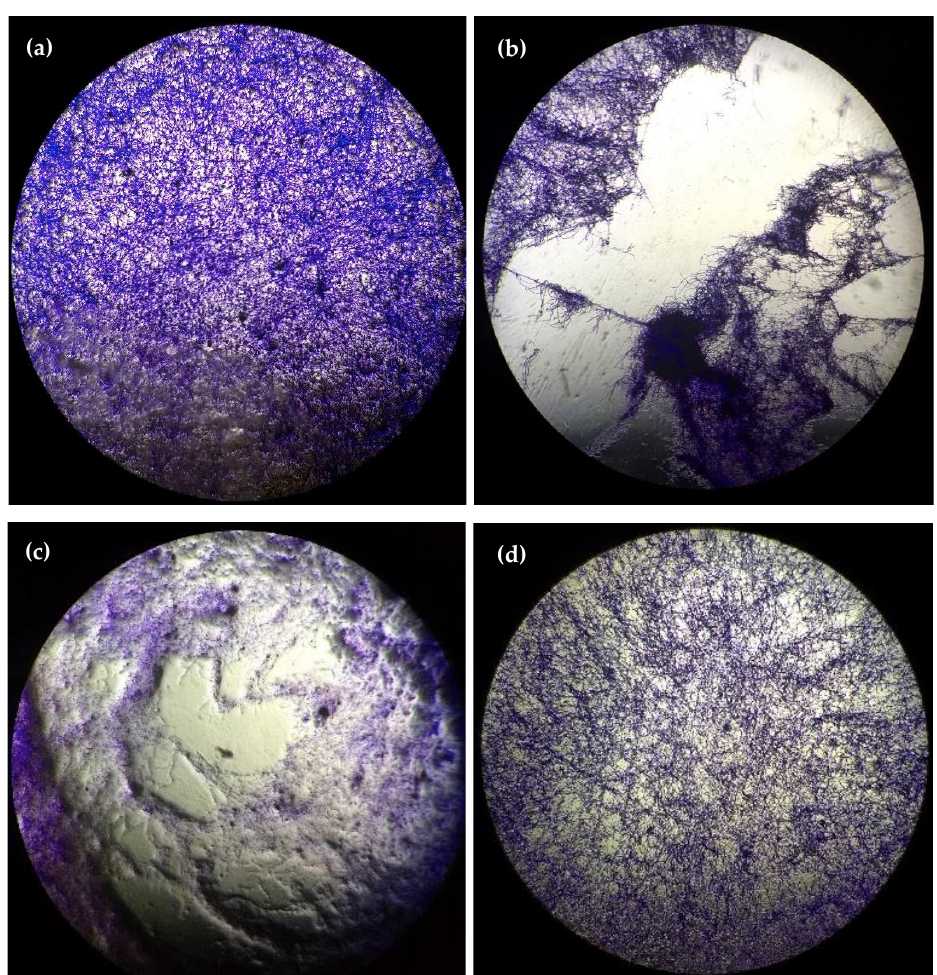
Figure 3. Microscopy images at 4× magnification of well-plate grown biofilms using crystal violet staining under different treatment conditions showing the ( a ) untreated biofilm control, ( b ) mechanically shred biofilm immediately after high-energy (0.55 mJ/mm 2 ) EM shockwave treatment, ( c ) Amp-B-treated biofilm after 12 h, and ( d ) combination of Amp B + medium energy (0.19 mJ/mm 2 ) EH shockwave treatment after 12 h.